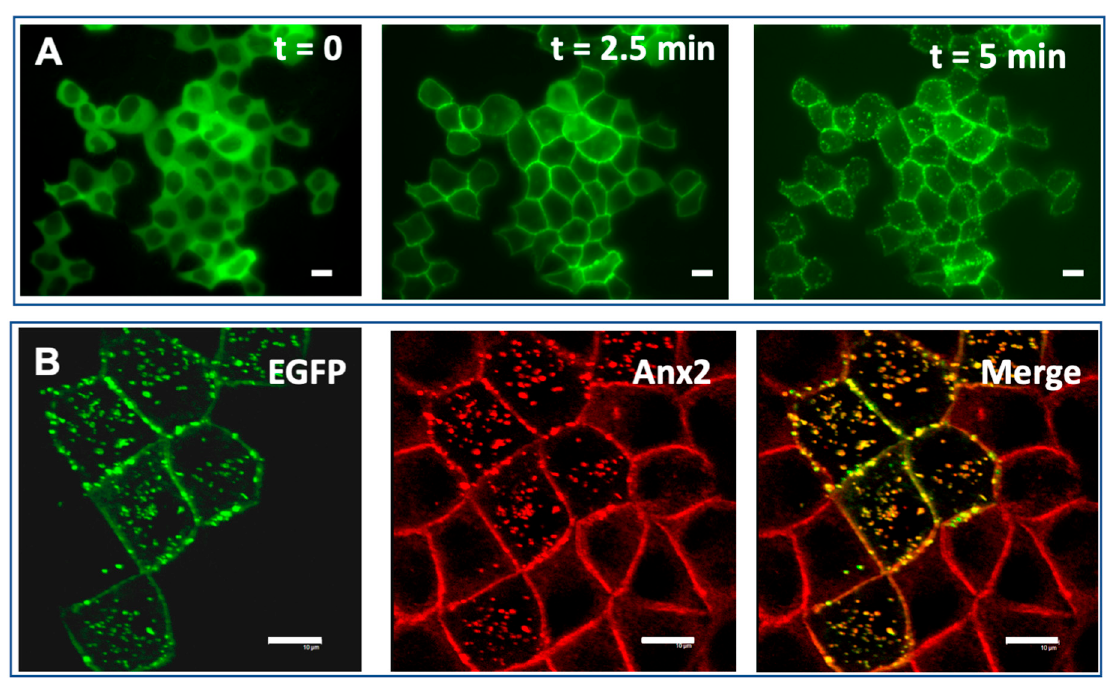
Figure 4. The AHNAK1 C-terminus binding motif specific for the Annexin2 / S100A10 (residues 5645-5673) induces formation of membrane vesicles. ( A ) Confluent MDCK cells transfected with plasmid expressing four repeats of the 20-amino acid peptide A2tBP1 (residues 5645-5673) fused to EGFP were incubated in medium containing 5 mM EGTA and supplemented with 1mM MgCl2 for 10 min at 37 ◦ C (t = 0), then shifted to calcium containing medium for 2.5 min (t = 2.5 min) and 5 min (t = 5 min). The subcellular distribution of A2tBP1 4 -EGFP during Ca 2 + switch experiments was recorded by live fluorescence imaging. ( B ) The translocation of A2tBP1 4 -EGFP to the plasma membrane and vesicles follows that of the annexin2. Confluent MDCK cells transfected with A2tBP1 4 -EGFP (green) were subjected to Ca 2 + switch experiment, fixed after 10 min and immunostained with annexin2 antibody (red).